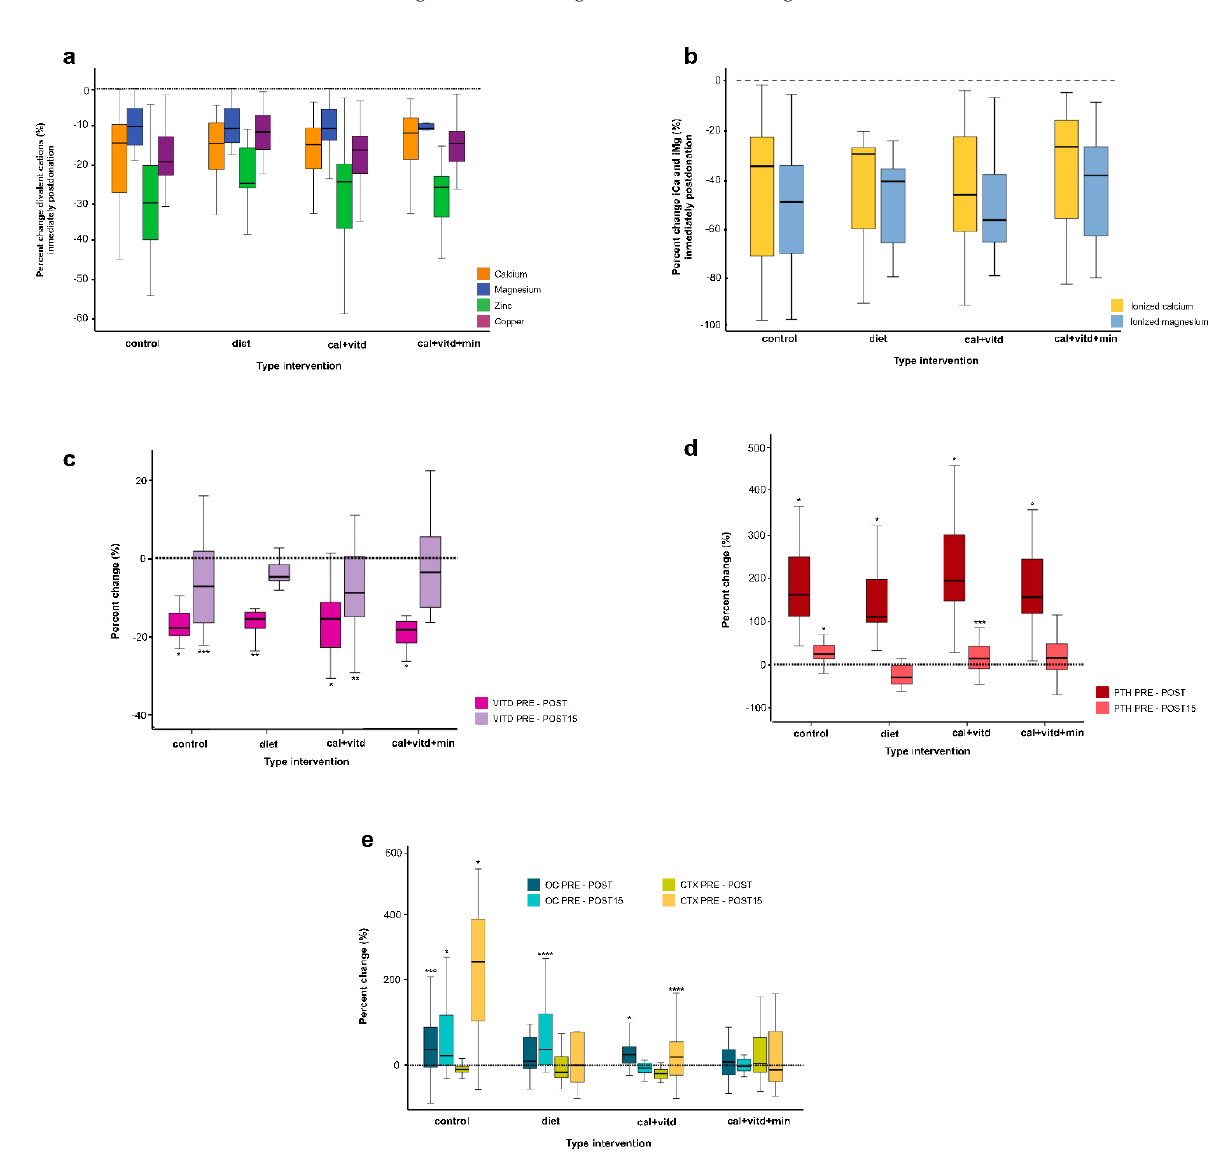
Metabolic Changes